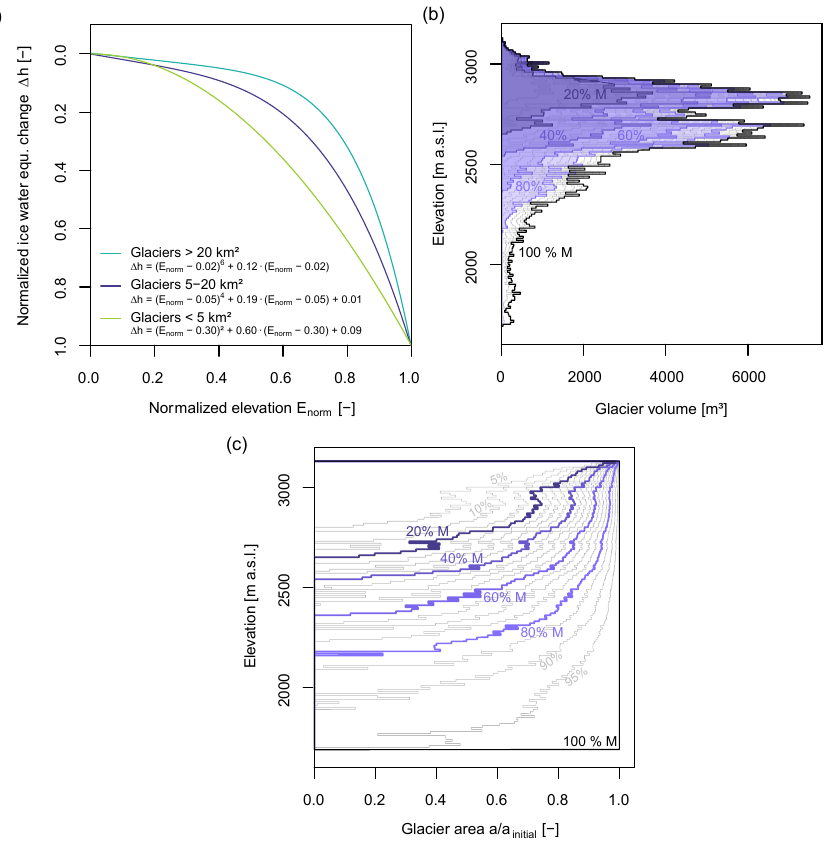
Figure 2. The (cid:49)h parameterization and its implementation in HBV-light: (a) empirical (cid:49)h parameterization functions for three glacier size classes from Huss et al. (2010), (b, c) pre-simulation application of the (cid:49)h parameterization for a medium glacier size to the example glacier profile data of the Alpbach catchment by melt in steps of (cid:49)M = 1% M to generate the lookup table. Panel (b) shows the absolute glacier volume per elevation band; panel (c) shows the relative glacier area per elevation band as relative fraction of the initial glacier area a initial of the elevation interval. For each elevation interval, the resulting glacier water equivalent/glacier volume (b) and glacier area (c) are shown as grey lines; for visibility, only results of steps of (cid:49)M = 5% are shown here. The initial profile (100% M) and profiles for a glacier volume reduction by 20, 40, 60, and 80% are highlighted by coloured labelled